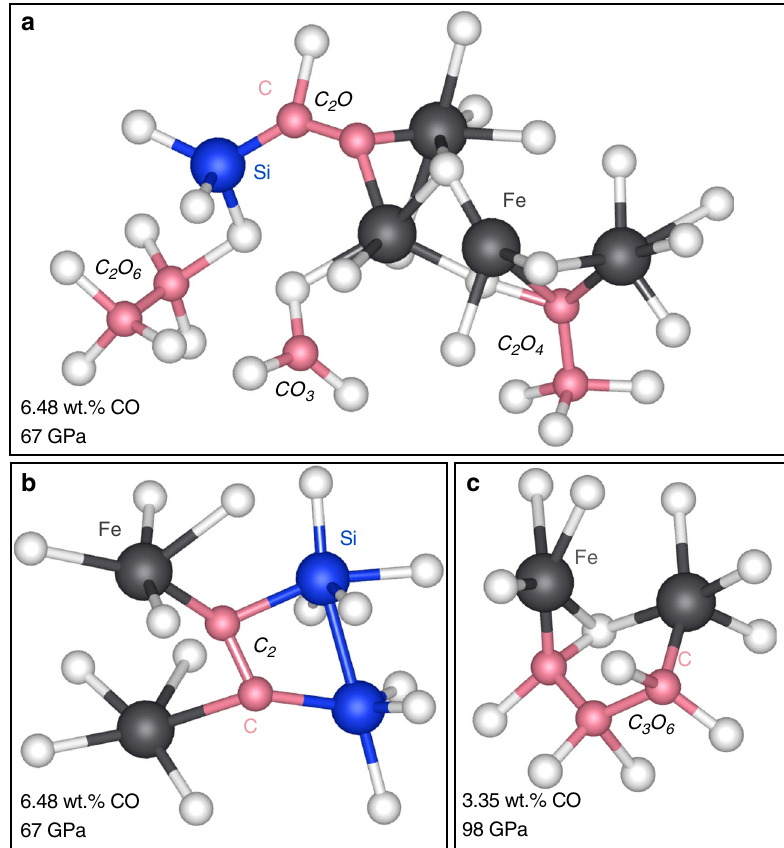
Fig. 3 Examples of carbon bonding to iron and silicon in pyrolite melt at 4000 K. a , b Pyrolite + 8CO (6.48 wt% CO) at 67 GPa and c pyrolite + 4CO (3.35 wt% CO). The carbon species that each carbon cluster represents is indicated in italics. Atoms that are not directly bonded to the cations shown here have been omitted for